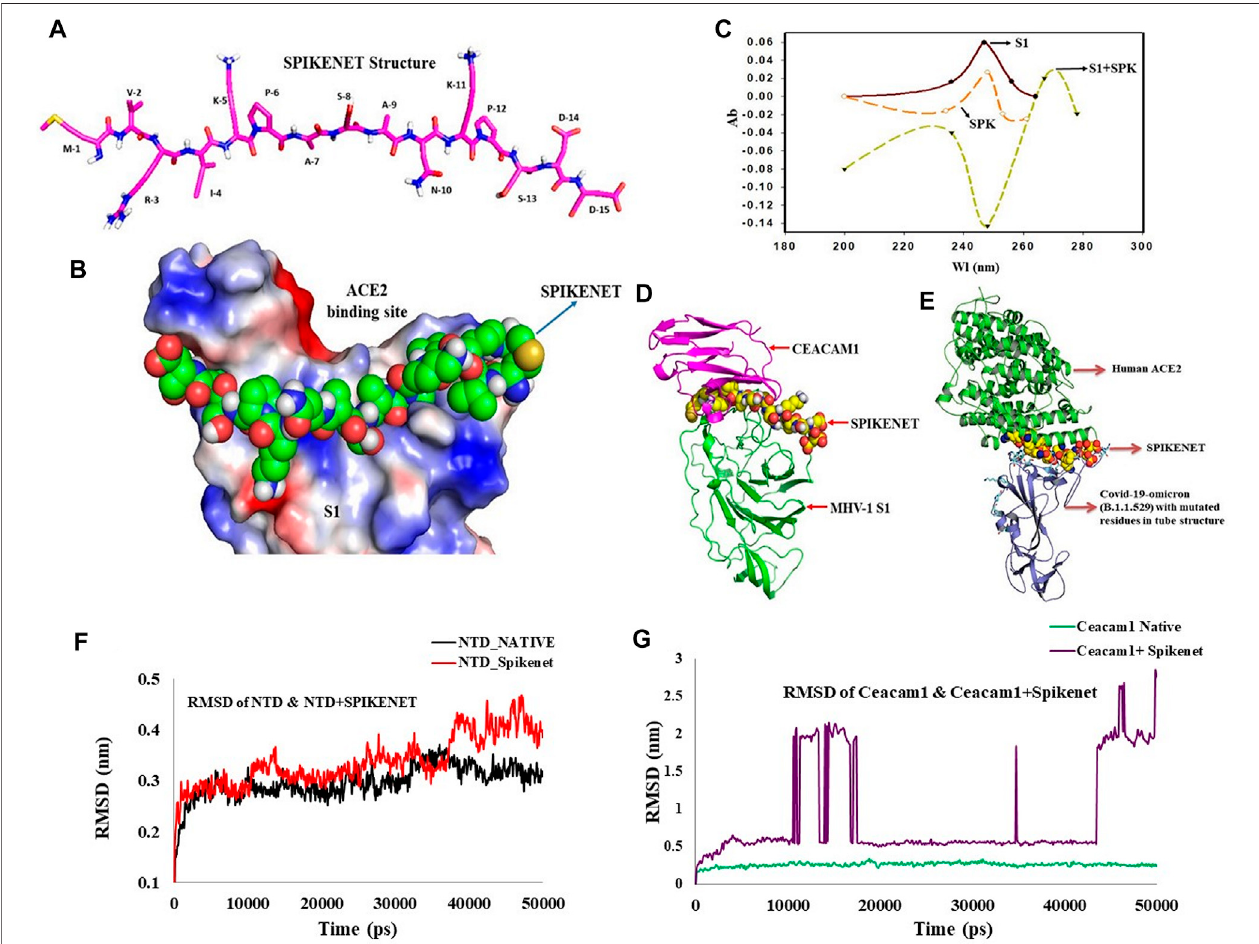
FIGURE1| SPIKENETStructure andBindingAf fi nitytotheACE2BindingDomainoftheSARS-CoV-2SpikeGlycoprotein. (A) StructureofSPIKENET,a15amino acid synthetic peptide targeted to the ACE2 binding domain of the SARS-CoV-2 spike glycoprotein. (B) Computational protein docking approach shows highly speci fi c SPIKENET binding af fi nity to the ACE2 binding domain of the SARS-CoV-2 spike glycoprotein (S1). (C) Spectroscopic analysis shows highly speci fi c SPIKENET (SPK) binding af fi nity to the ACE2 binding domain of the SARS-CoV-2 spike glycoprotein (S1). (D) High af fi nity binding of SPIKENET to the CEACAM1 binding domain of the MHV-1 spike glycoprotein: Computer modeling studies. (E) highly speci fi c SPIKENET binding af fi nity to S1-RBD of the recently identi fi ed Omicron SARS-CoV-2 variant. Ab, absorbance; Wl, wavelength. High af fi nity binding of SPIKENET to the CEACAM1 binding domain of the MHV-1 spike glycoprotein. High af fi nity binding of SPIKENET to the CEACAM1 binding domain of the MHV-1 spike glycoprotein: Computer modeling studies. Ab, absorbance; Wl, wavelength. High af fi nity binding of SPIKENET to the CEACAM1 binding domain of the MHV-1 spike glycoprotein: Con fi rmatory computer molecular dynamic studies. The RMSD of both complexes with their respective native proteins are shown in (F,G) . Comparing the RMSD of both NTD and NTD + SPK (F) after 50 ns dynamic simulation, the structures showed complete equilibration inthe system and the SPK peptide waswell stabilizedwith high af fi nityat theCCM binding location ofNTD. However, the RMSD analysis ofCCM andCCM+SPKstructuresafterthe50 nsdynamicsimulationexhibitedmore fl exibilityattheNTDbindingsiteofCCMthannativeCCM (G) ,suggestingtheSPKpeptide detachment and displacement over the CCM.